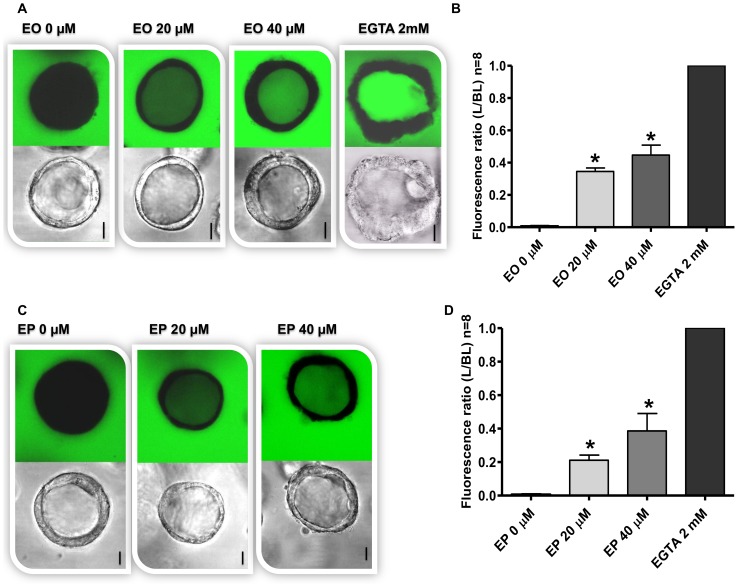
Effect of ethyl oleate (EO) and ethyl palmitate (EP) on paracellular permeability in 3D Caco-2 spheroids.[A] Spheroids were treated or not treated with either EO (20, 40 µM), EGTA (positive control) or [C] EP (20, 40 µM) in the presence of FITC-dextran-4 at 37 °C for 24 h. Intraluminal accumulation of FITC-dextran-4 (green) was observed using confocal microscopy and representative images captured from the middle of spheroids are shown. The bar indicates 10 µm. The mean fluorescence intensity of FITC-dextran-4 after exposure to [B] EO and [D] EP was measured and expressed as the ratio of the luminal (L) over the basal (BL) compartment. The L/BL ratio as determined following EGTA exposure was set to 1. All graphs indicate the results of three replicate experiments. Data expressed as means±SD, *p<0.0001, compared to medium only-treated control.